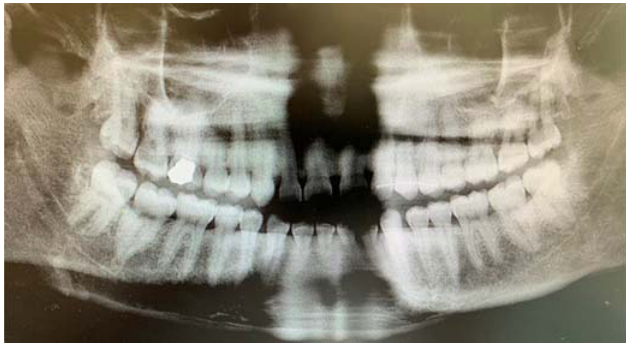
Fig. 3. Immediate post operative orthopantommogram.